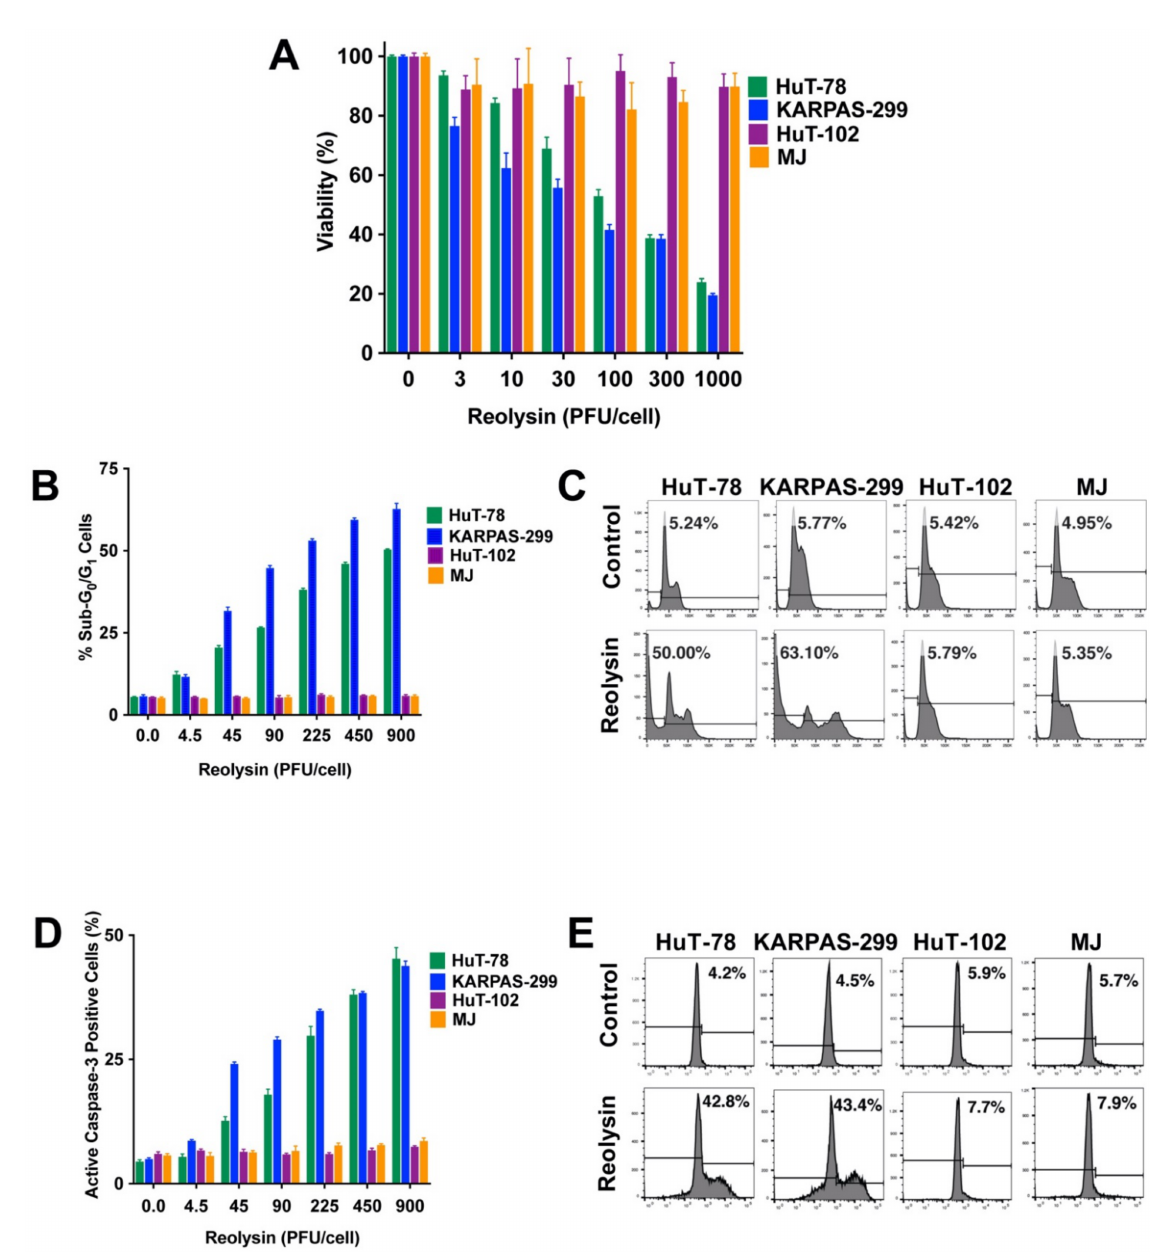
Figure 1. Reolysin exhibits anticancer efficacy against HuT-78 and KARPAS-299 TCL cells. ( A ) Effects of Reolysin on TCL cell viability. TCL cells were treated with the indicated concentrations of Reolysin for 72 h. Cell viability was measured by MTT assay. Mean ± SD, n = 3; ( B , C ) Reolysin induces DNA fragmentation in HuT-78 and KARPAS-299 TCL cells. TCL cells were treated with the indicated concentrations of Reolysin for 48 h. Induction of apoptosis was measured by PI-FACS analysis. Representative histograms are presented in untreated (Control) cells and cells treated with 900 PFU/cell Reolysin for 48 h. ( D , E ) Reolysin induces active caspase-3 in HuT-78 and KARPAS-299 cells. Cells were treated with the indicted concentrations of Reolysin for 48 h, and active caspase-3 levels were determined by active caspase-3 fluorescent staining followed by flow cytometry. Representative histograms are presented in untreated (Control) cells and cells treated with 900 PFU/cell Reolysin for 48 h. Mean ± SD, n =